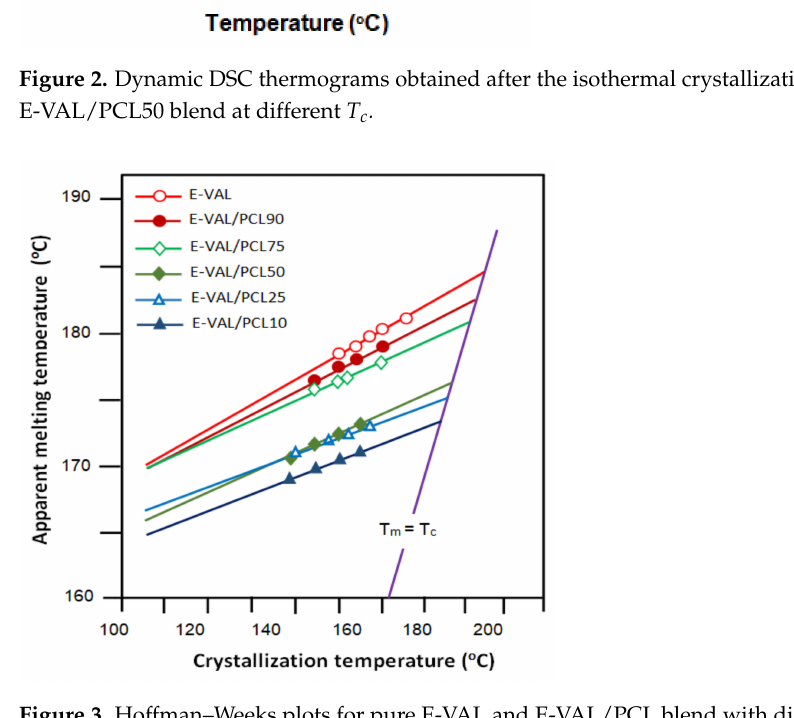
Figure 3. Hoffman–Weeks plots for pure E-VAL and E-VAL/PCL blend with different